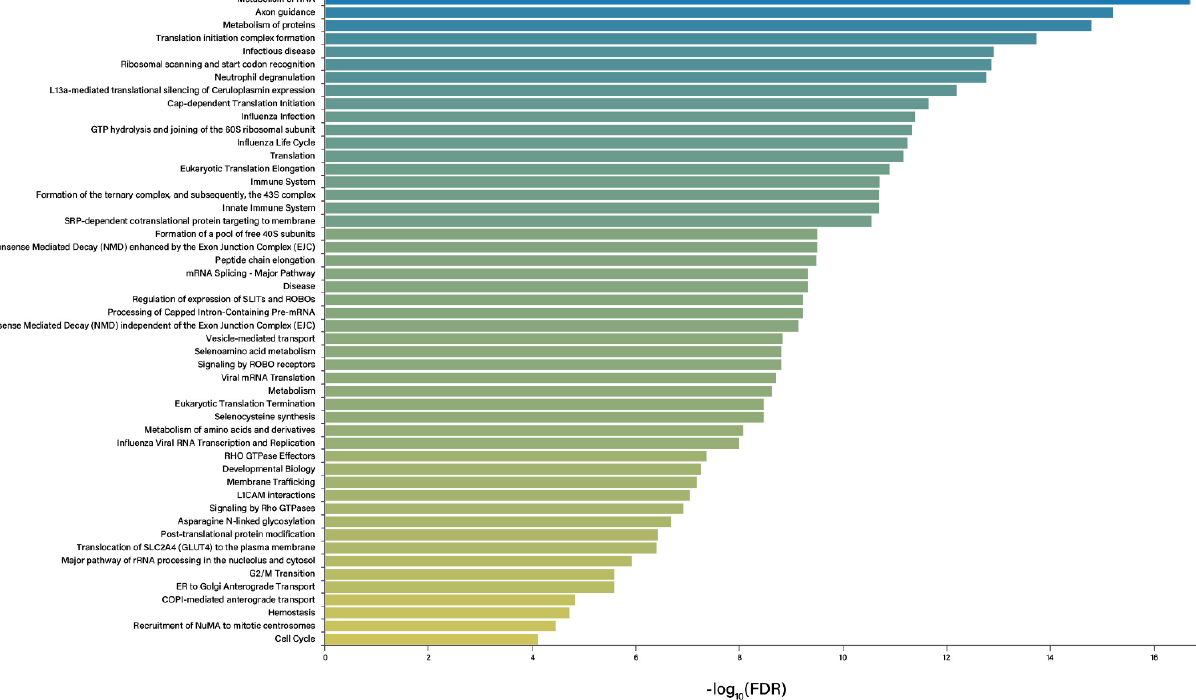
Figure 1. Reactome Pathways. Differentially expressed proteins are involved in 212 biological pathways with FDR ≤ 0.05. The bar plot shows the top 50 biological pathways. FDR values were transformed to a negative base 10 logarithm, which means that larger values on the abscissa axis indicate better-represented pathways.